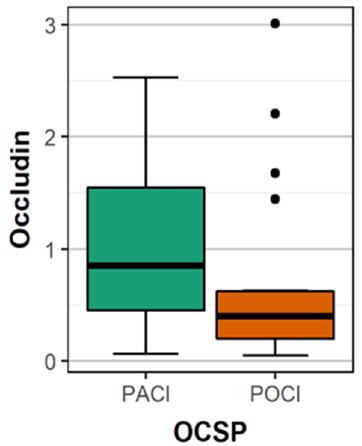
Figure 1. The comparison of the mean concentration of occludin between patients with PACI and POCI. Table 2. The mean concentrations of occludin, claudin 5, and ZO-1 associated with the location of the ischemic focus in the artery supply.